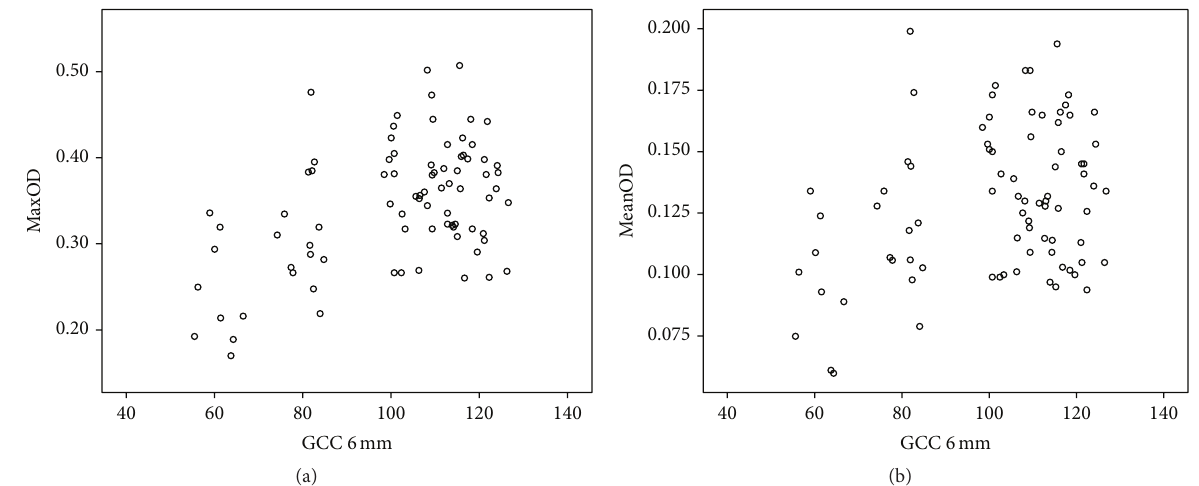
Figure 1: Scatter plot depicting the correlation between GCC thickness and MPOD. (a) Positive relation between maxOD and GCC. (b) Positive relation between meanOD and